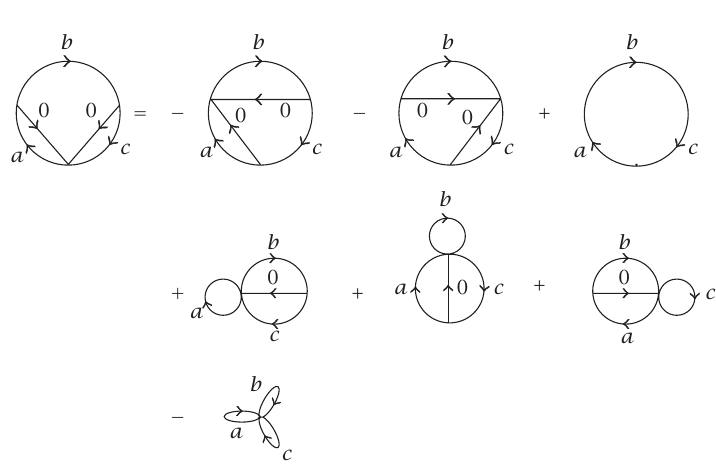
Figure 4.5 . Diagrammatic identity derived from the three-point